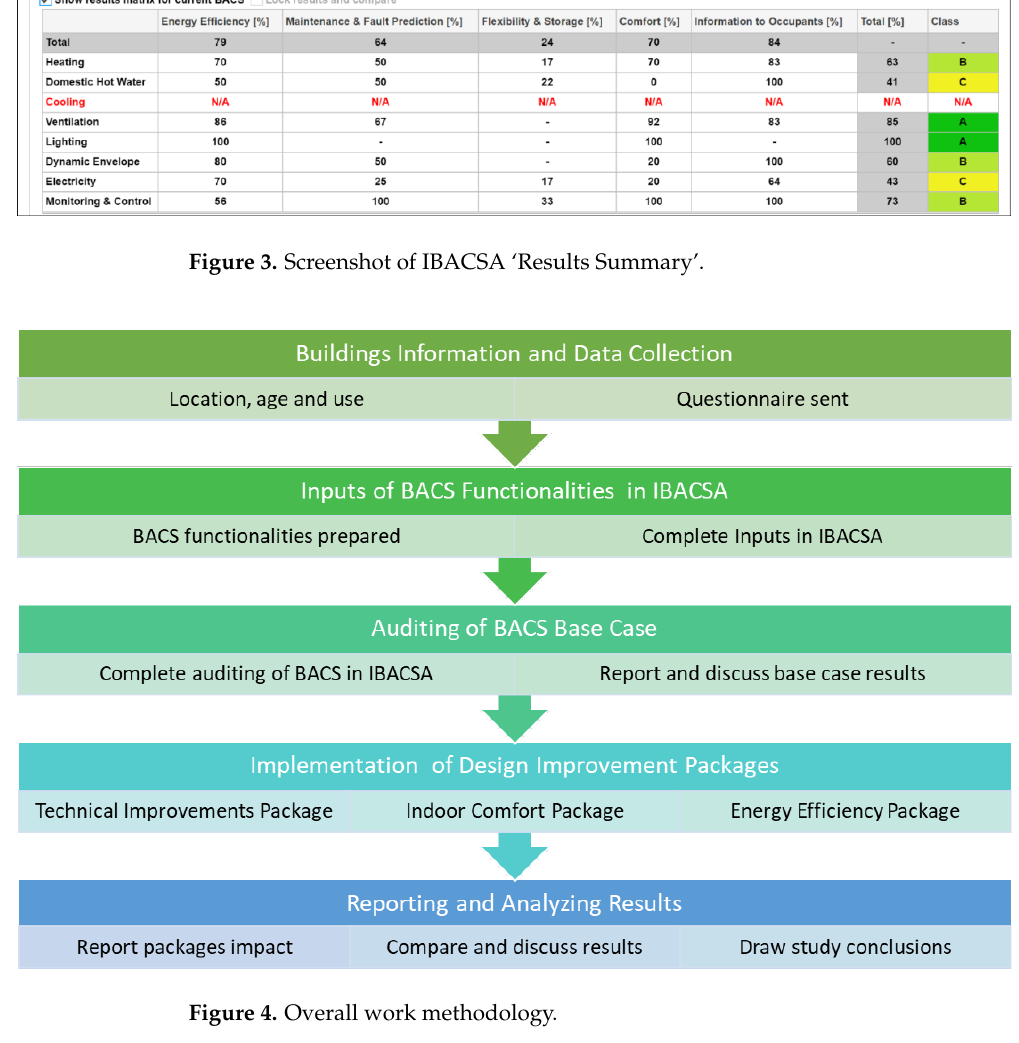
Figure 3. Screenshot of IBACSA ‘Results Summary’.